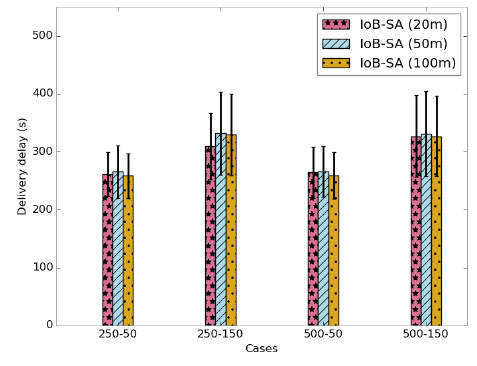
Figure 26. Average delivery delay for IoB-SA.